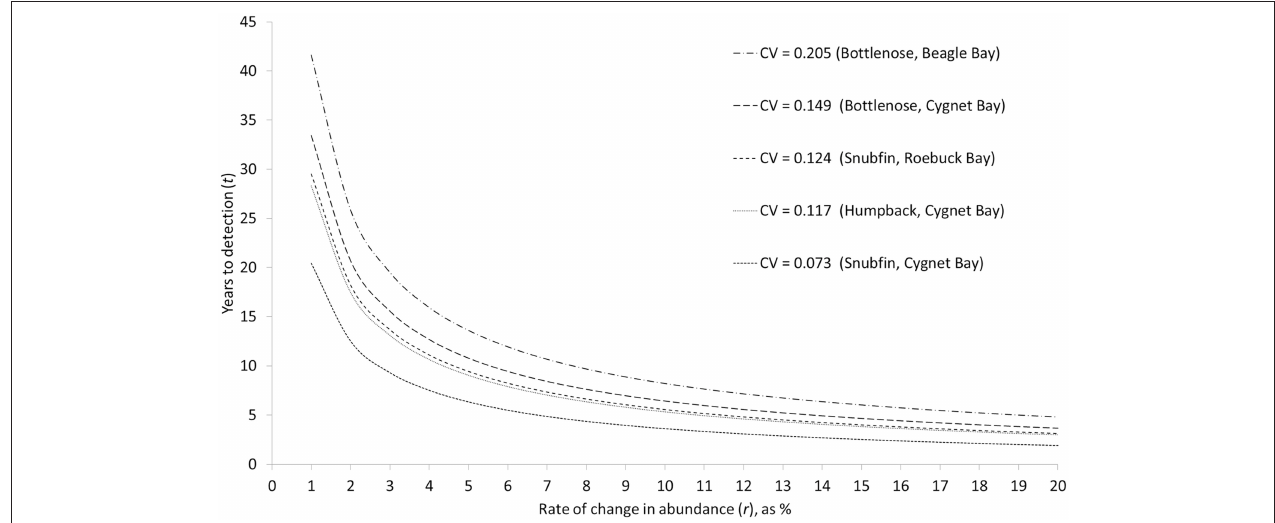
FIGURE 4 | Relationship between different rates of change in abundance ( r ), and the time required to detect such a change ( t ) with a statistical power of 95%, given different levels of precision (CV) in annual abundance estimates. CVs are the mean CV of abundance estimates for single sampling periods.